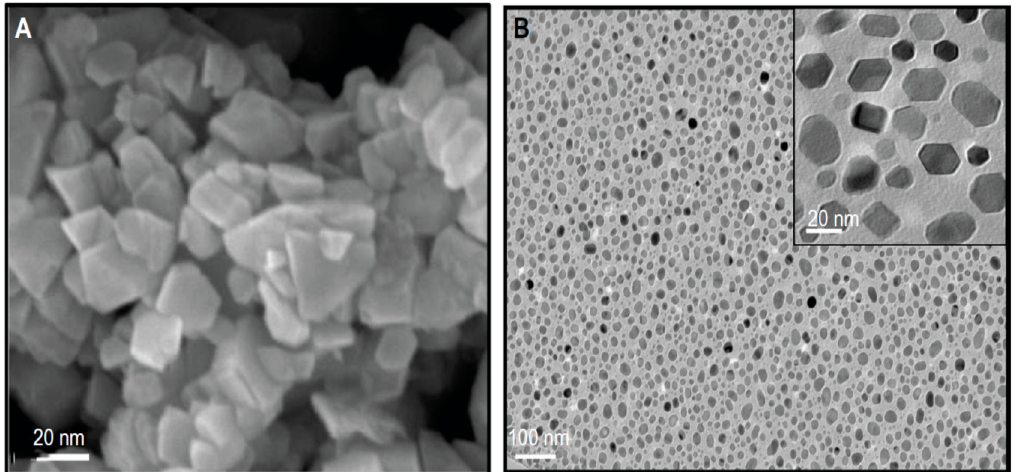
Figure 13. ( A ) SEM and ( B ) transmission electron microscope (TEM) images of ZnO nanoparticles (NPs) prepared by co-precipitation process using zinc acetate dihydrate and NaOH. Inset in ( B ) shows a high-magnified TEM image of hexagonal shaped ZnO NPs. Reproduced from [212] under a Creative Commons